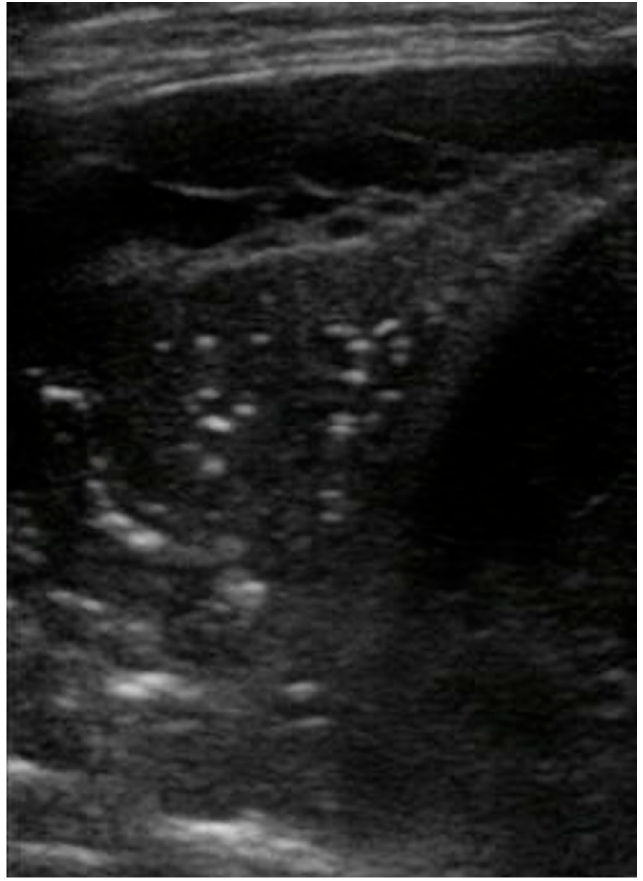
Figure 2. Complex pleural effusion associated with bacterial pneumonia: presence of fibrinous strands and septations (echogenic appearance) in the typical anechoic image related to fluid.